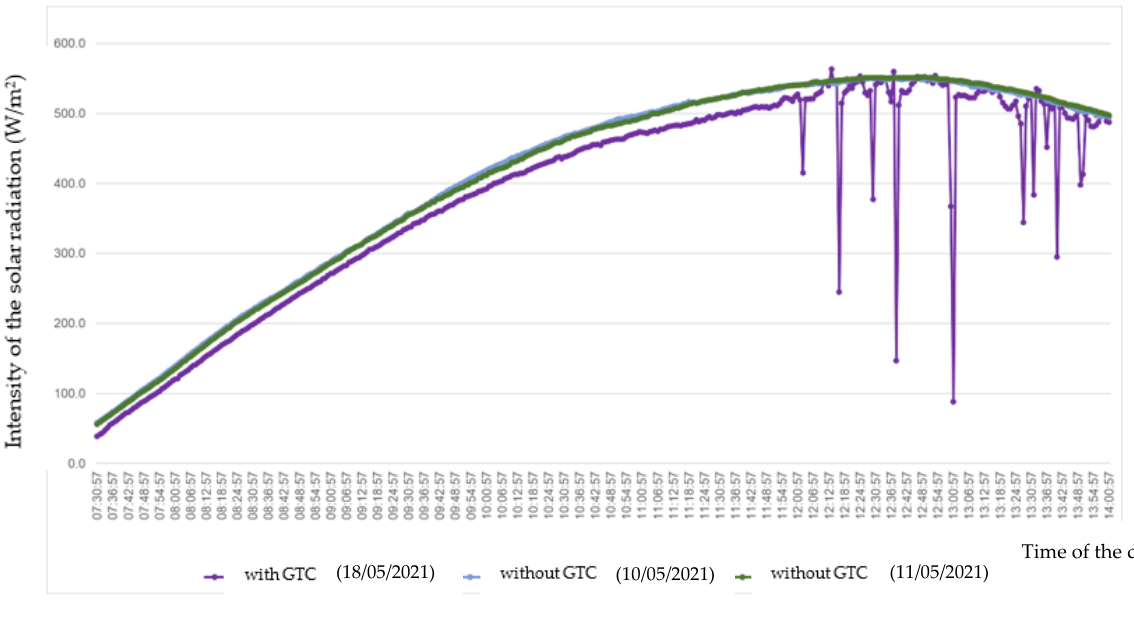
Figure 13. Days chosen for analysis: solar radiation intensity.